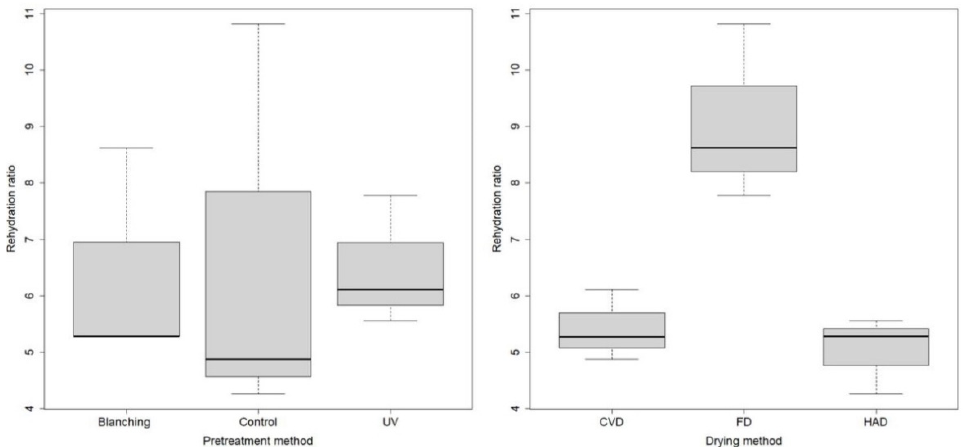
Figure 2. Boxplot of the rehydration ratio of B. edulis dried mushrooms in relation to pretreatment for all dried samples, and in relation to drying for all pretreated samples.